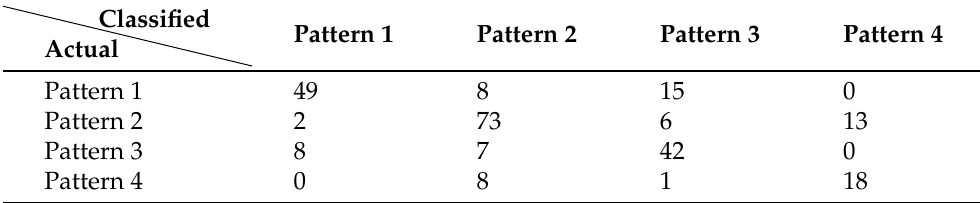
Table 4. Confusion matrix for pattern recognition.